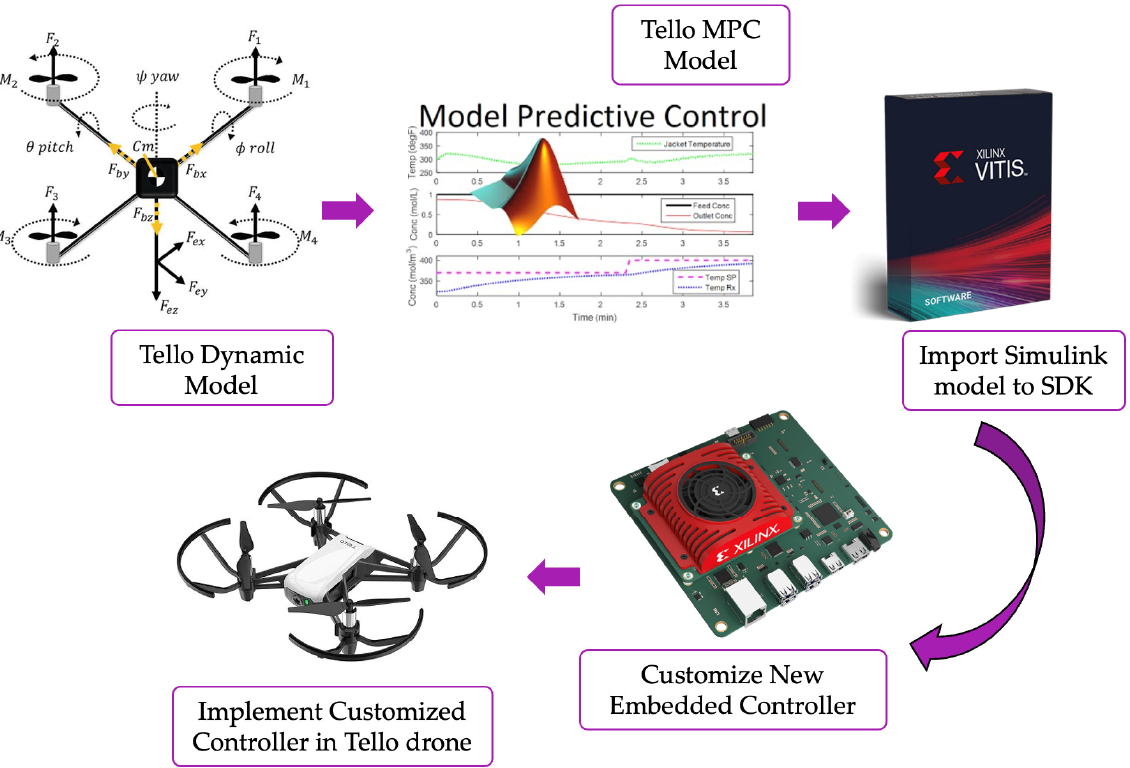
Figure 2. The plan for building the customized embedded system for Tello Edu.